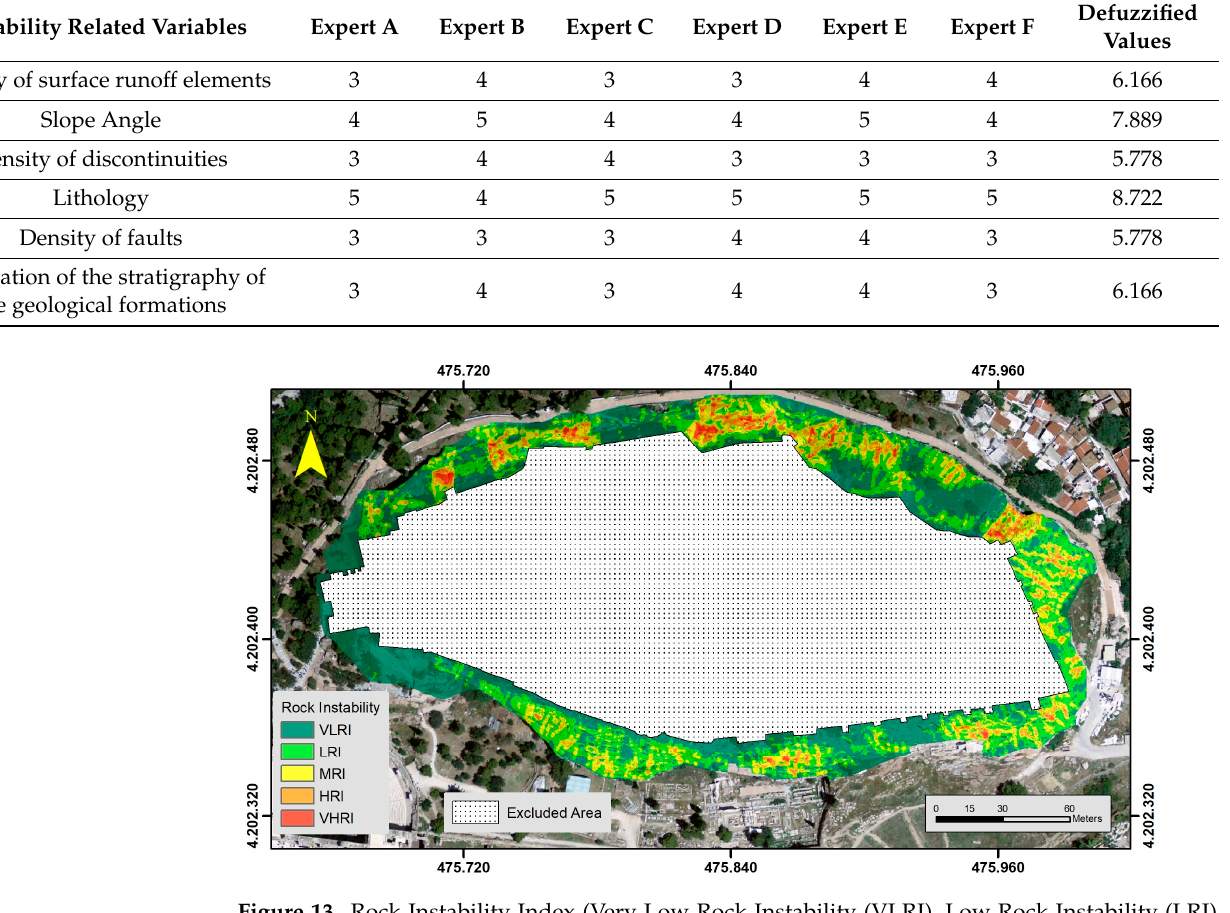
Figure 13. Rock Instability Index (Very Low Rock Instability (VLRI), Low Rock Instability (LRI), Moderate Rock Instability (MRI), High Rock Instability (HRI), Very High Rock Instability (VHRI)).